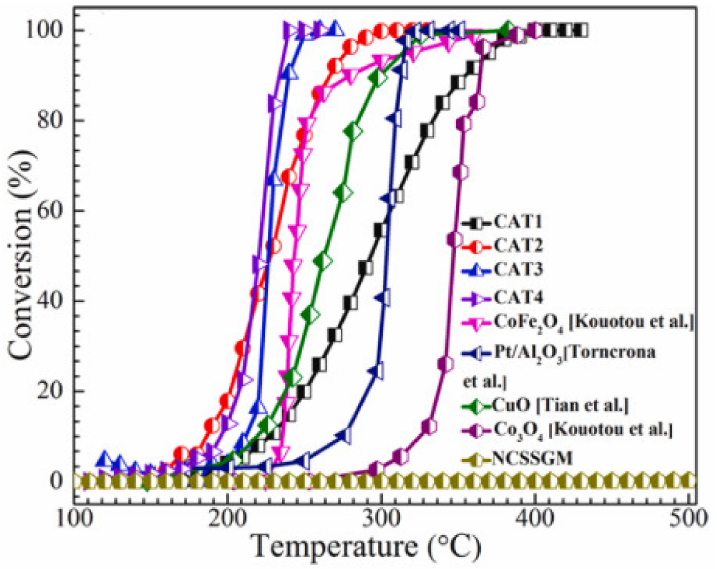
Figure 12. Light-off curves of CO complete oxidation over FeCuO x (CAT1 → 4) and other known catalysts (reproduced from Ref.